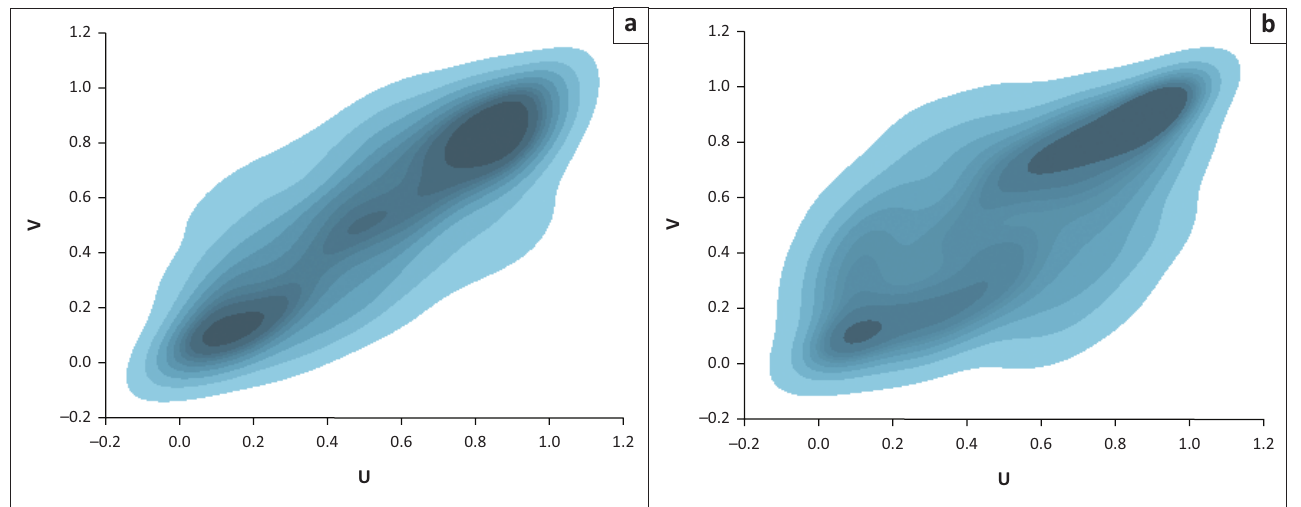
FIGURE 7: Contour plots of the dependence structures observed for ZAR and BRL where the Frank copula covers the 6-month period ending June 2009 and the Gumbel copula the 6-month period ending June 2020 (a–b).